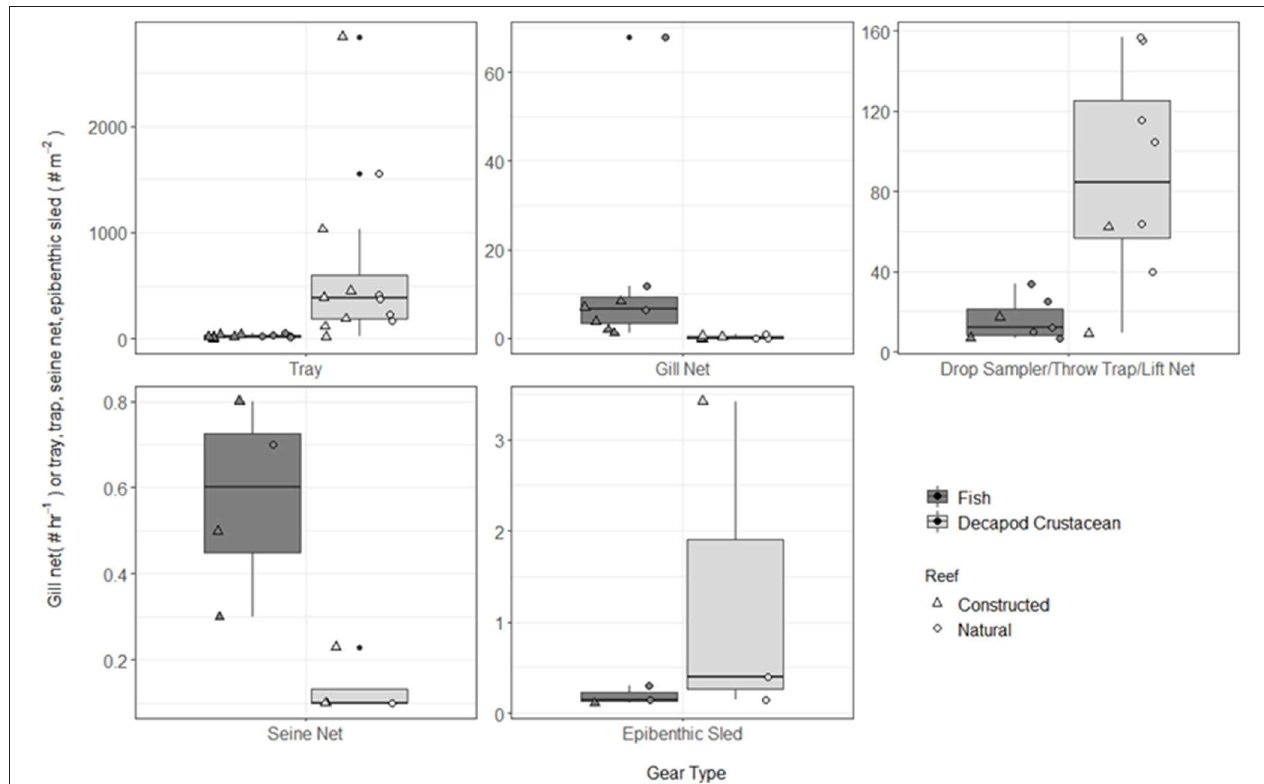
FIGURE 4 | Boxplot of fish and decapod crustacean density presented by gear type TR, tray; GN, gill net; DS, drop sampler; LN, lift net; TT, throw trap; SN, seine; ES, epibenthic sled. Note different y-axes for each gear type. Box represents 25, 50, and 75% quantilets, with whiskers at ± 1.5*IQR.